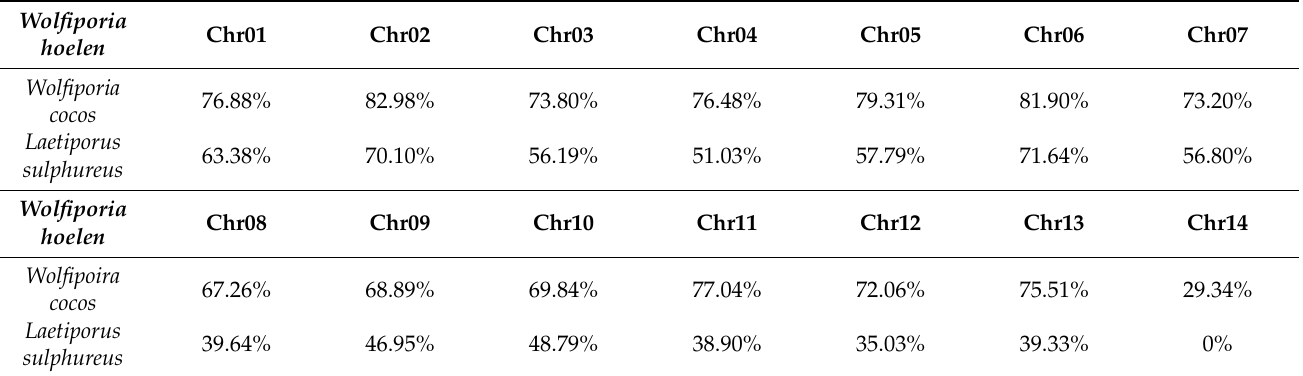
Table 3. Protein collinear ratio of different chromosomes comparing Wolfipoira hoelen , Wolfiporia cocos , and Laetiporus sulphureus